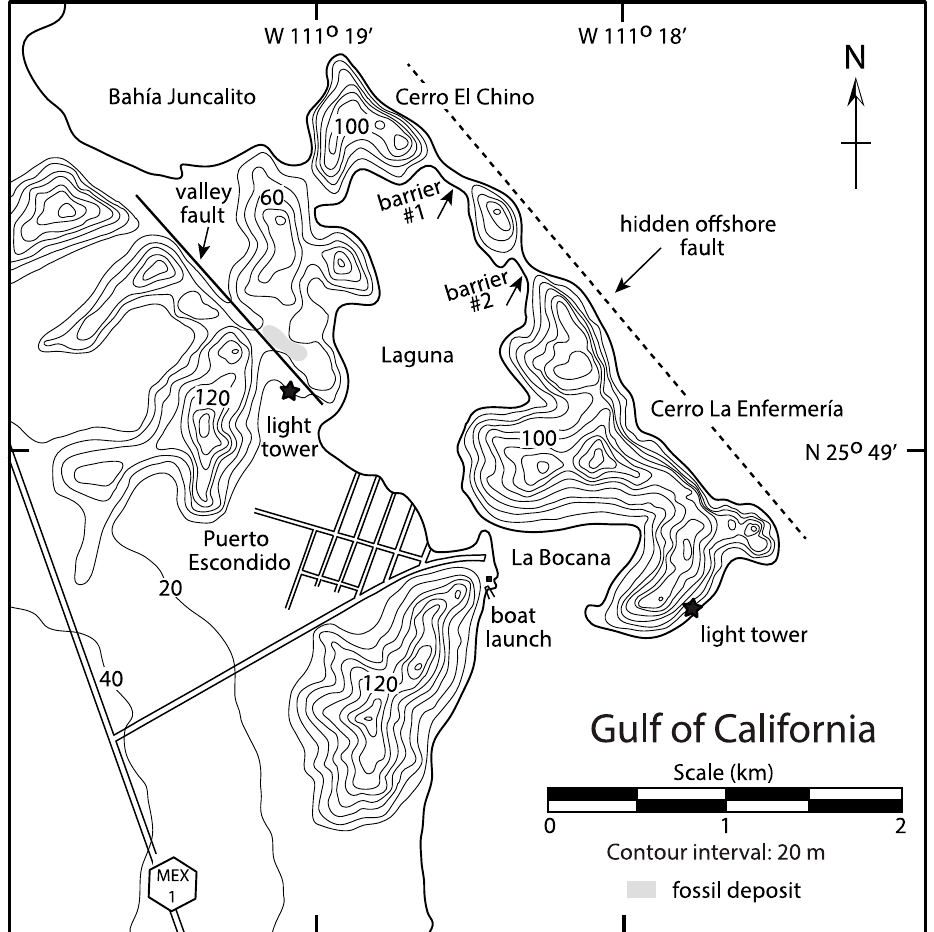
Figure 4. Topographic map showing the hills surrounding Puerto Escondido and other key features including a Pleistocene fossil deposit and faults.